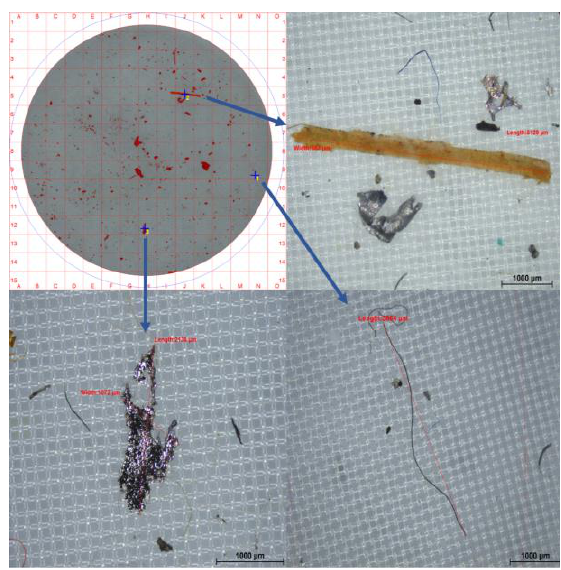
Fig. 6. Mesh membrane filter (overall view, upper left) with metallic (lower left), non-metallic (upper right) and fibrous (lower right)